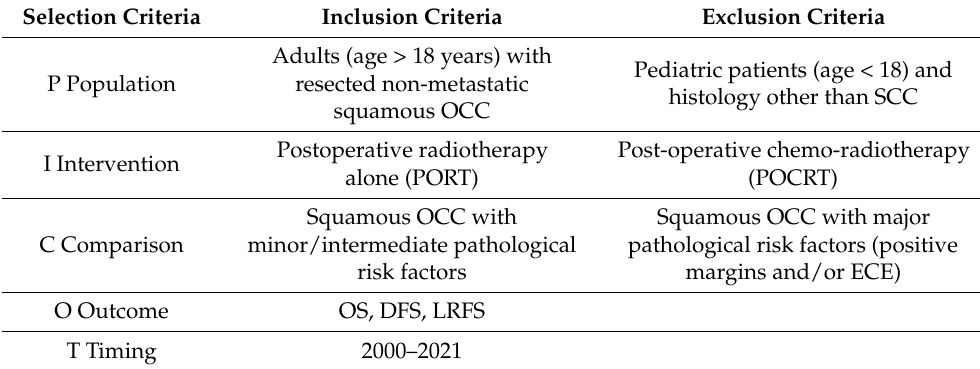
Table 1. Criteria for study selection according to PICOT model.